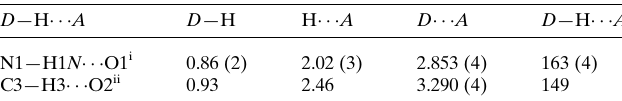
Table 1 Hydrogen-bond geometry (A˚ , (cid:4) ) for (I). D —H (cid:2)(cid:2)(cid:2) A